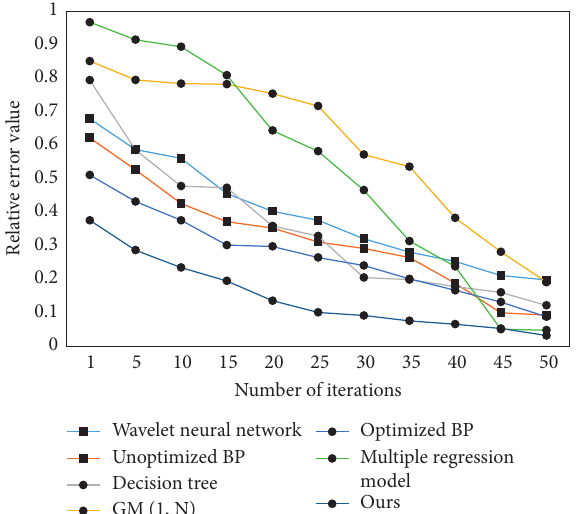
Figure 8: The relative error curve of the predicted value of the single prediction model and the combined model in this paper.